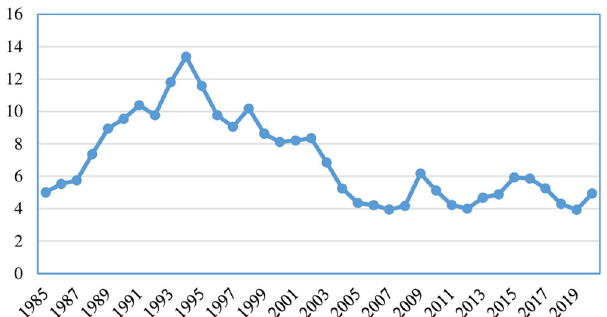
Fig. 2 RMO as a percentage of GDP. Source: Word Bank (2021).